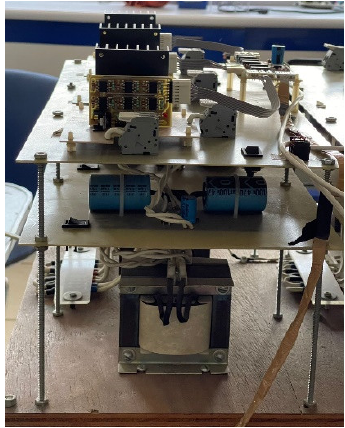
Figure 13. Experimental platform, multilevel topology.